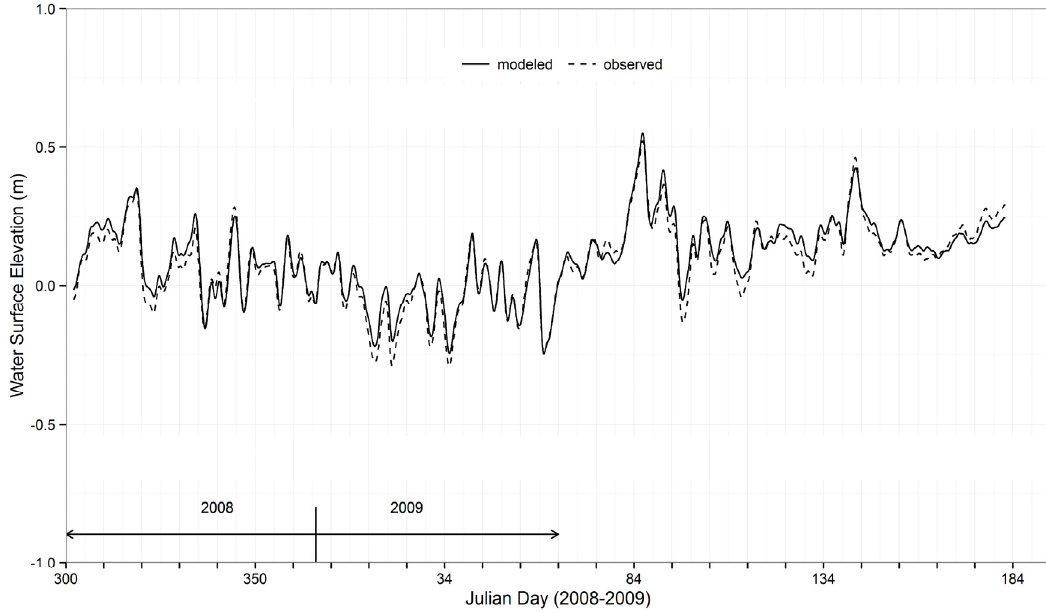
Figure 2. Modeled and observed filtered water surface elevations at Terry Cove from 27 October 2008 (Julian Day 300) to 3 July 2009 (Julian Day 184).